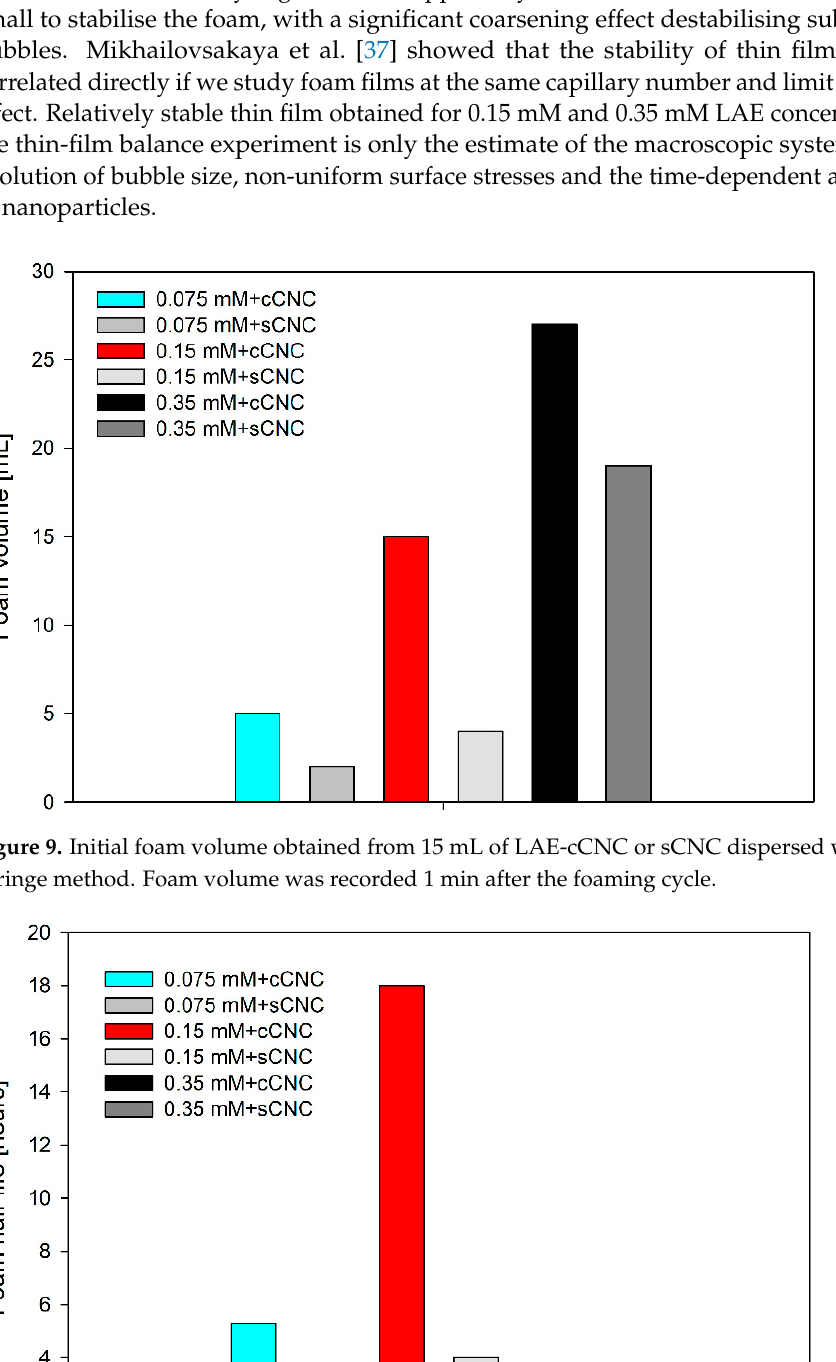
Figure 10. The half-life of foams formed in the CNC-LAE suspensions with the double-syringe Figure 10. The half ‐ life of foams formed in the CNC ‐ LAE suspensions with the double ‐ syringe method.